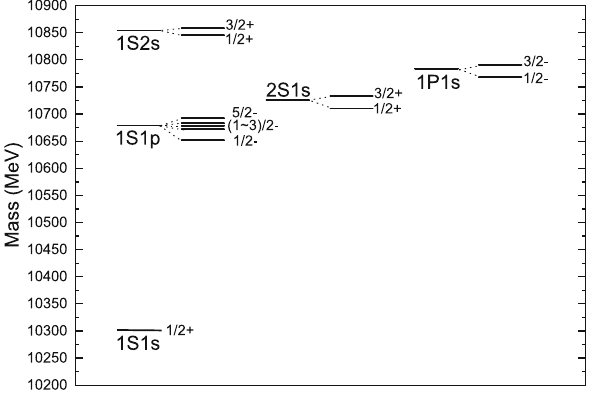
Fig. 6 Mass spectrum (in MeV) of the (cid:3) bb baryons, corresponding to the Table 14